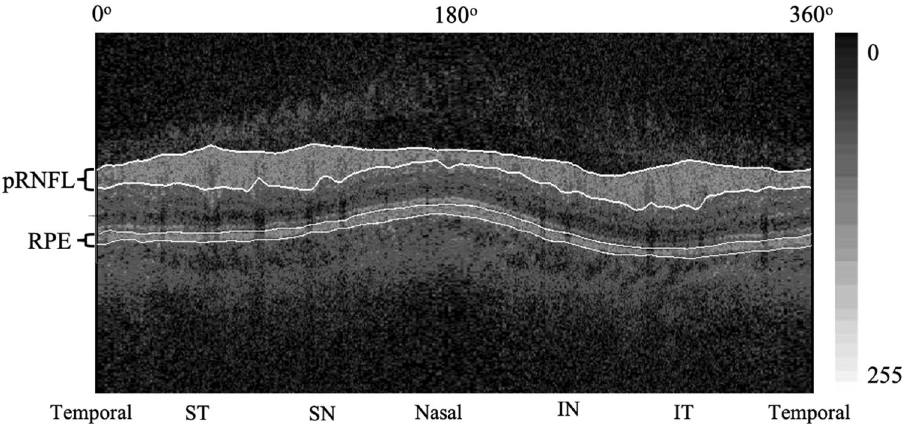
Figure 1. SD-OCT images of the pRNFL and RPE segmentation with grayscale value measurement.